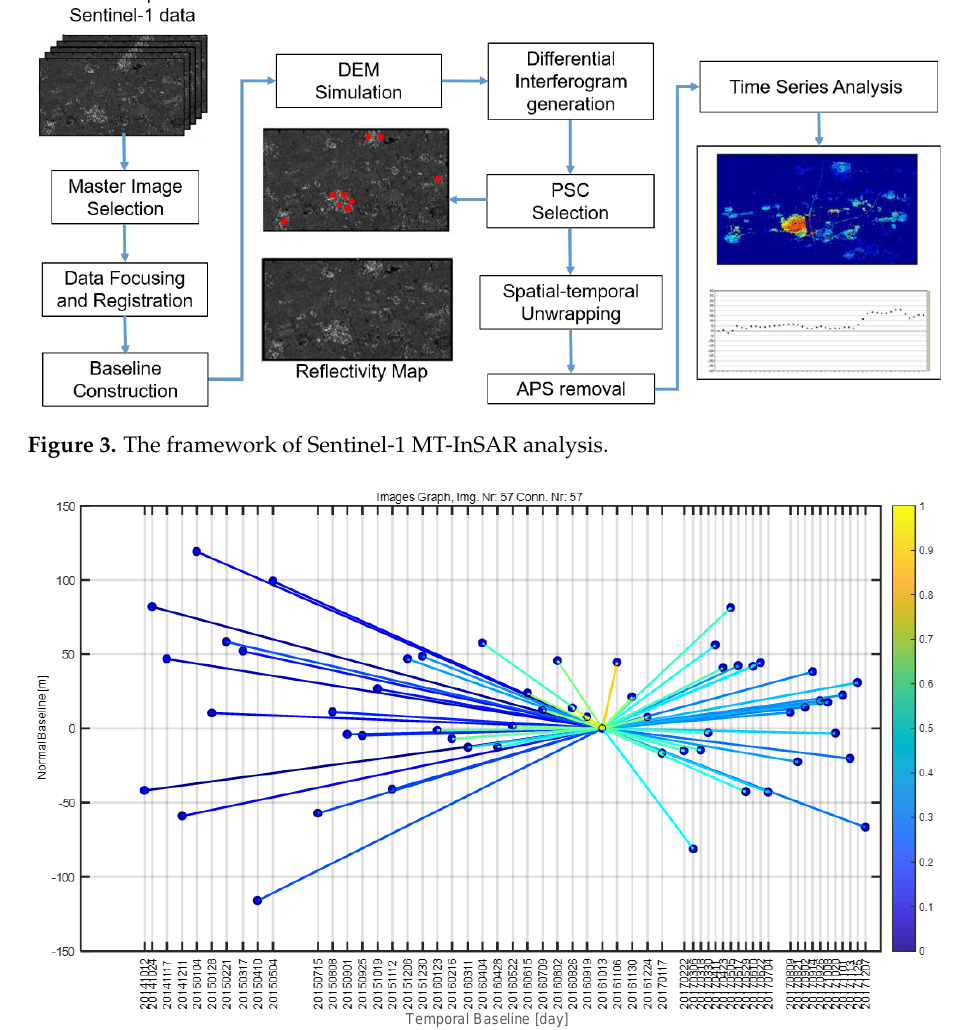
Figure 4. Image graph of Sentinel-1 A/B PSI analysis. x -axis: temporal baseline of the acquisitions. y -axis: normal baseline of the acquisitions. The centers of the connected lines are the reference images of the Sentinel-1 A/B dataset. The color bar represents the average coherence ranging from 0 to 1. Most on-orbit SAR satellites use a strip model as the default data collection